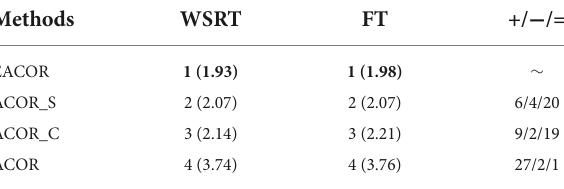
TABLE 4 Comparative results of strategy combination comparison